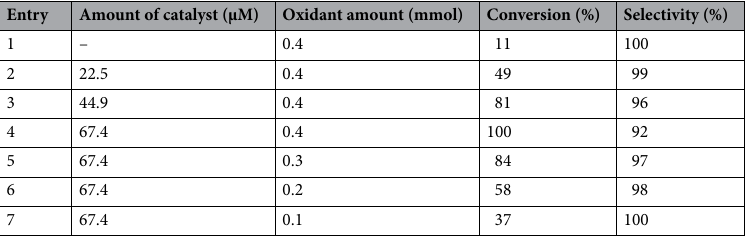
Table 1. The effect of various conditions on the methylphenyl sulfide to sulfoxide for 4 h in the presence of H 2 O 2 as an oxidant and water as solvent a . a GC